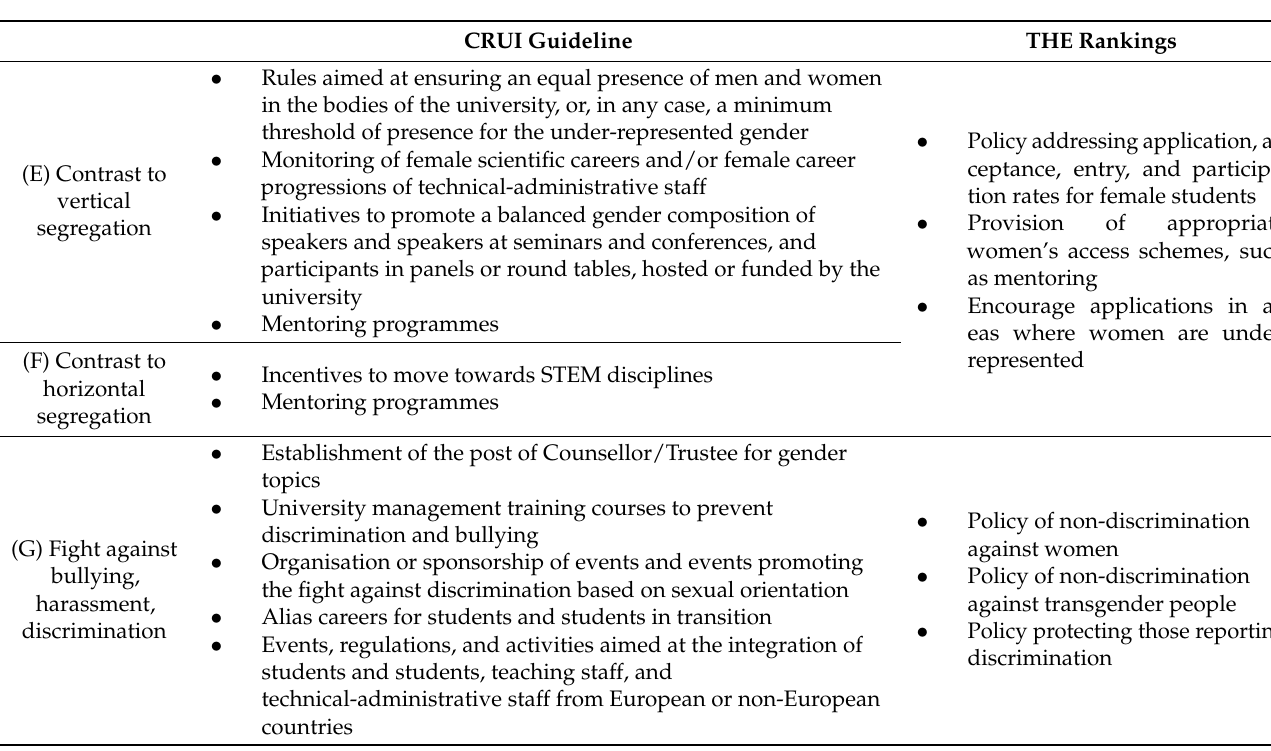
Table 1. Cont. CRUI Guideline THE